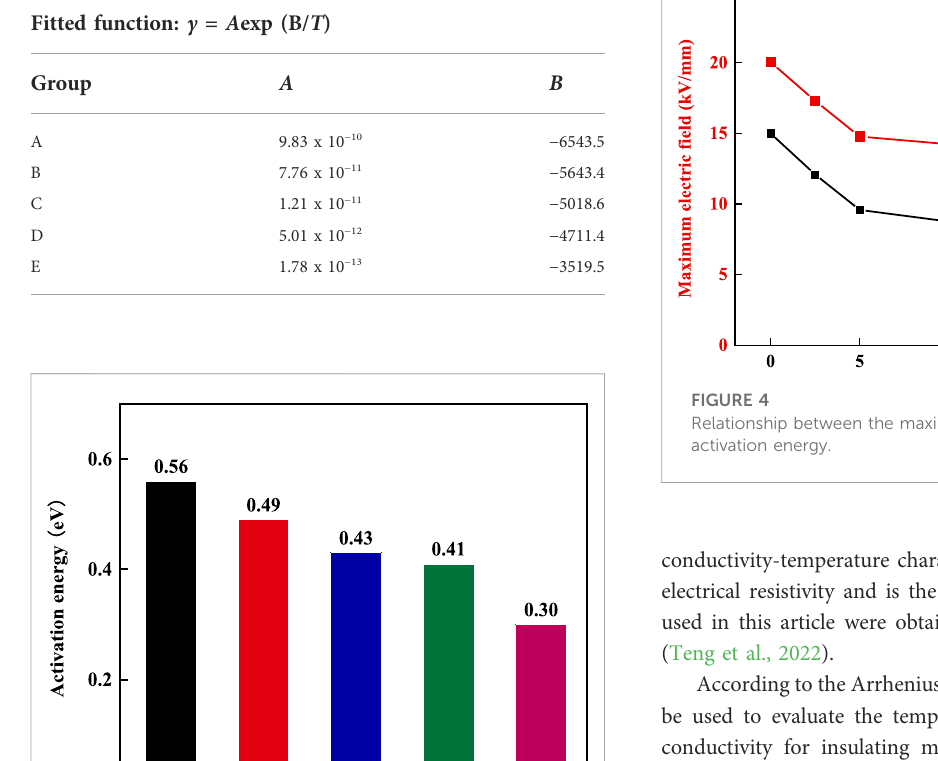
FIGURE 3 Activation energy of samples.